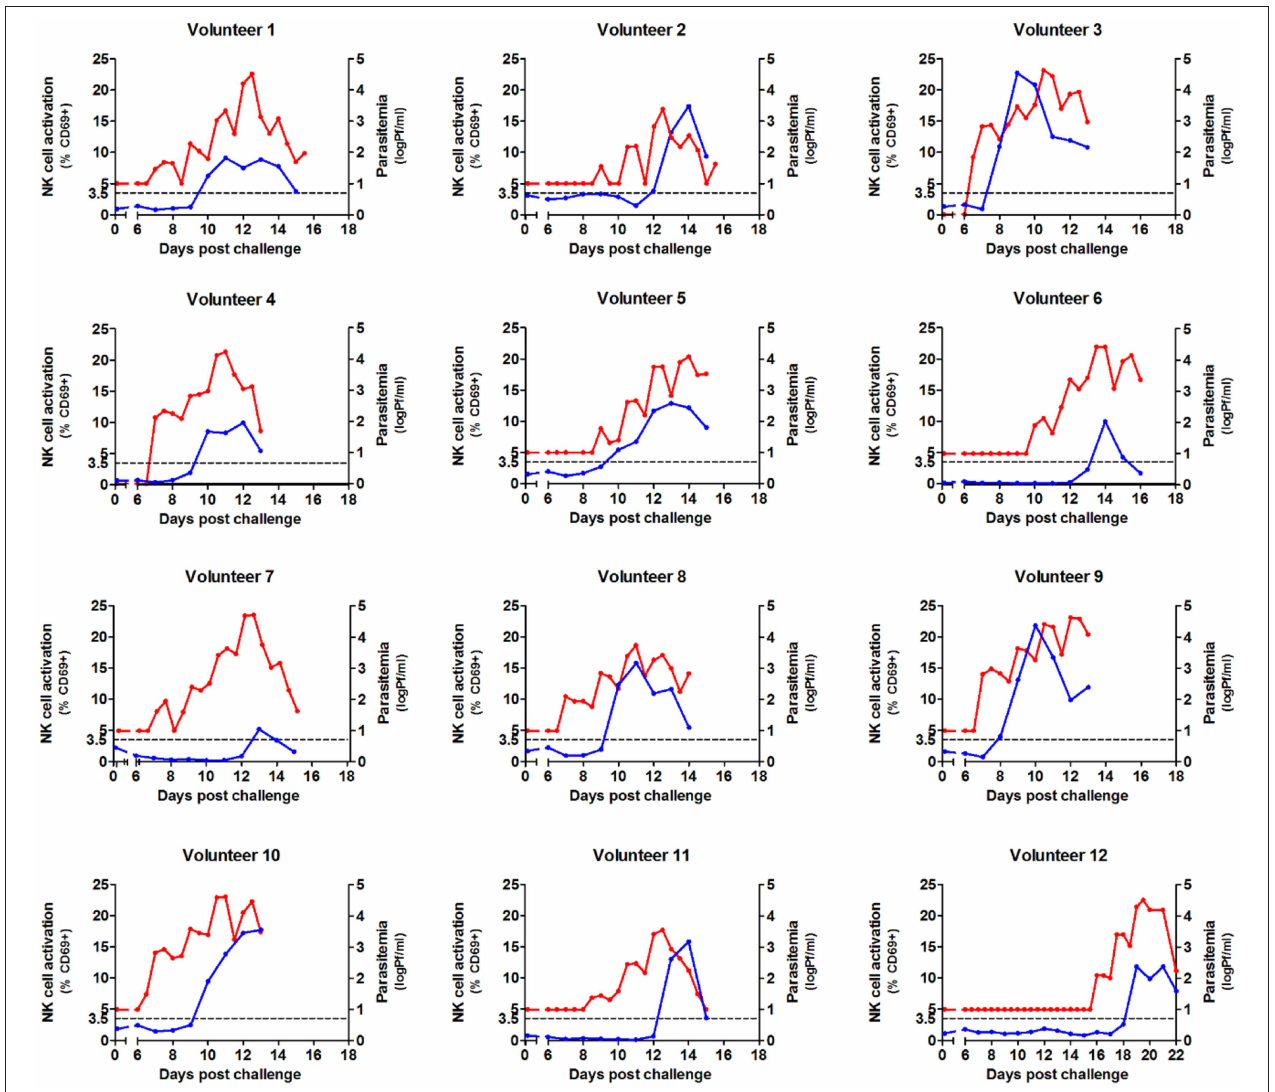
FIGURE 1 | Kinetics of parasitemia and NK cell activation during Controlled Human Malaria Infection. NK cells were analyzed by flow cytometry daily in whole venous blood from 12 volunteers undergoing Controlled Human Malaria Infection. Antimalarial treatment was initiated when parasite densities reached levels detectable by microscopy. Each graph shows the activation of NK cells (defined by CD69 surface expression) from day 6 post infection until day 3 after antimalarial treatment (blue line, left axis). The same graph shows parasitemia measured by qPCR from day 6 after infection, until day 3 after antimalarial treatment (red line, right axis). NK cell activation is first seen 1–2 days after the first appearance of parasitemia. Each graph represents the data gathered for a single volunteer ( n = 12).